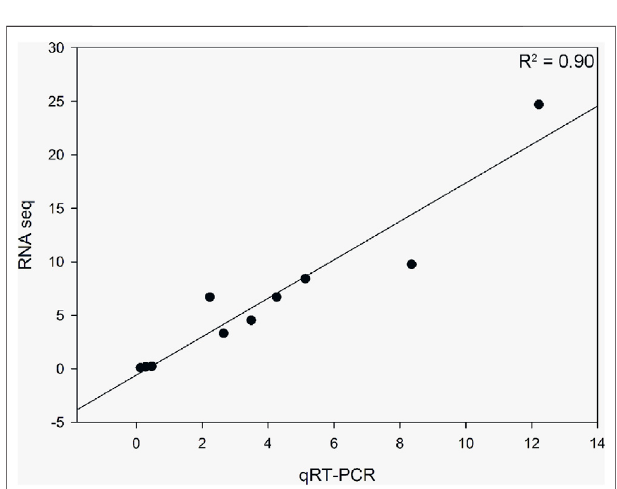
FIGURE 7 | Correlation analysis of 10 differentially expressed genes obtained from RNA-seq and qRT-PCR. The qRT-PCR values were normalized relative to the expression levels of ACTB1 in the same sample. Data are expressed as the mean of three biological replicates.